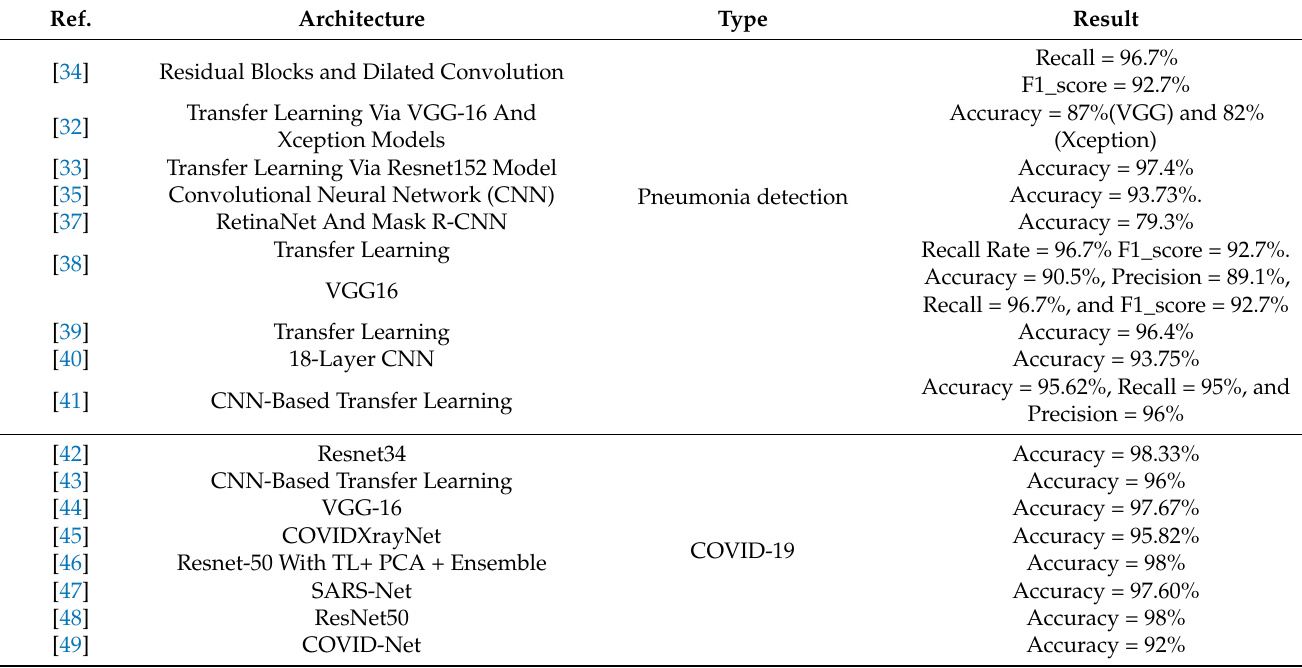
Table 1. Summary of the related works covering the author, the proposed architecture, the type of lung disease they tackled and the achieved